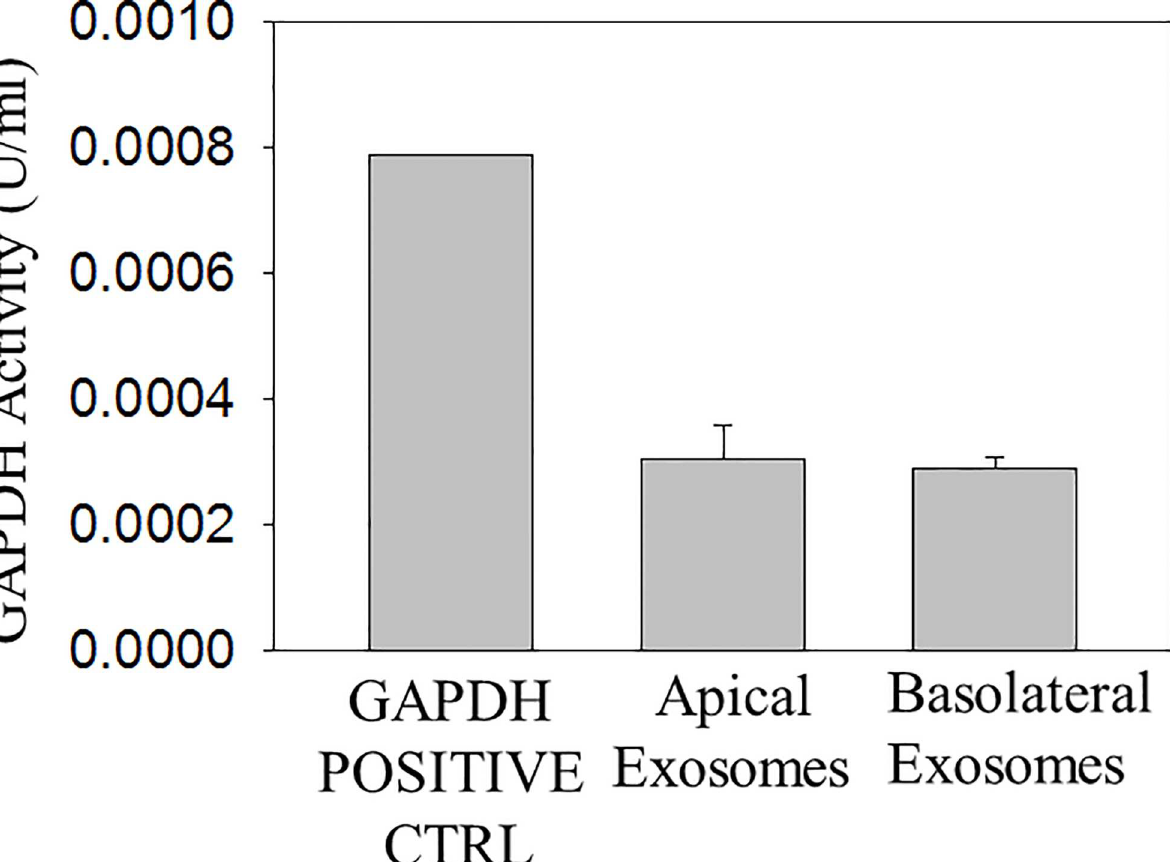
Fig 4. GAPDH activity in exosomes isolated from LLC-PK1 cells. Three batches of exosomes (n = 3) isolated from conditionedmedia of LLC-PK1 cells present in the apical compartment or basolateralcompartment of permeable transwell inserts were lysed in RIPA buffer. The Δ OD was calculated for the GAPDH activity in each sample by taking the difference in absorbance readingsbetween two time points that fell within an NADH standard curve generatedusing six different concentrations of NADH. All sample readingswere corrected for by subtracting the background readingfrom measuringthe OD of the background control mix alone. The NADH amount generated by GAPDH activity during the reaction time was calculated for each sample. GAPDH activity is expressed as U/ml where one unit of GAPDH is the amount of enzyme that will generate 1.0 μ mol of NADH per minute at pH 7.2 at 37˚C. OD represents optical density. Data is presented as mean ± s.e. from 3 separate batches of exosomes (N =